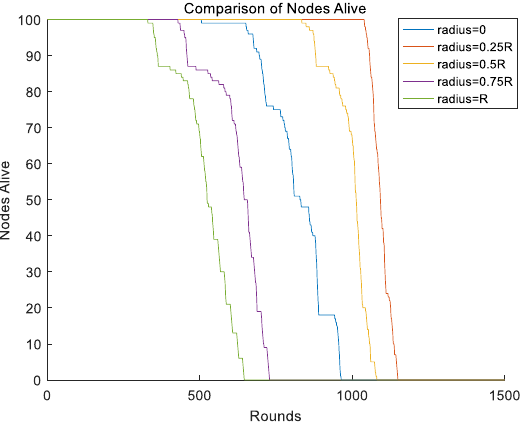
Figure 9. Different radius of mobile sink.